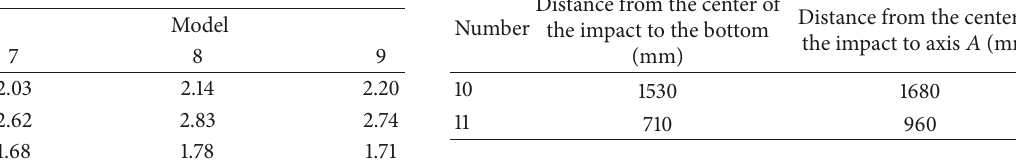
Table 9: Maximum displacements (mm) elicited by the three models.